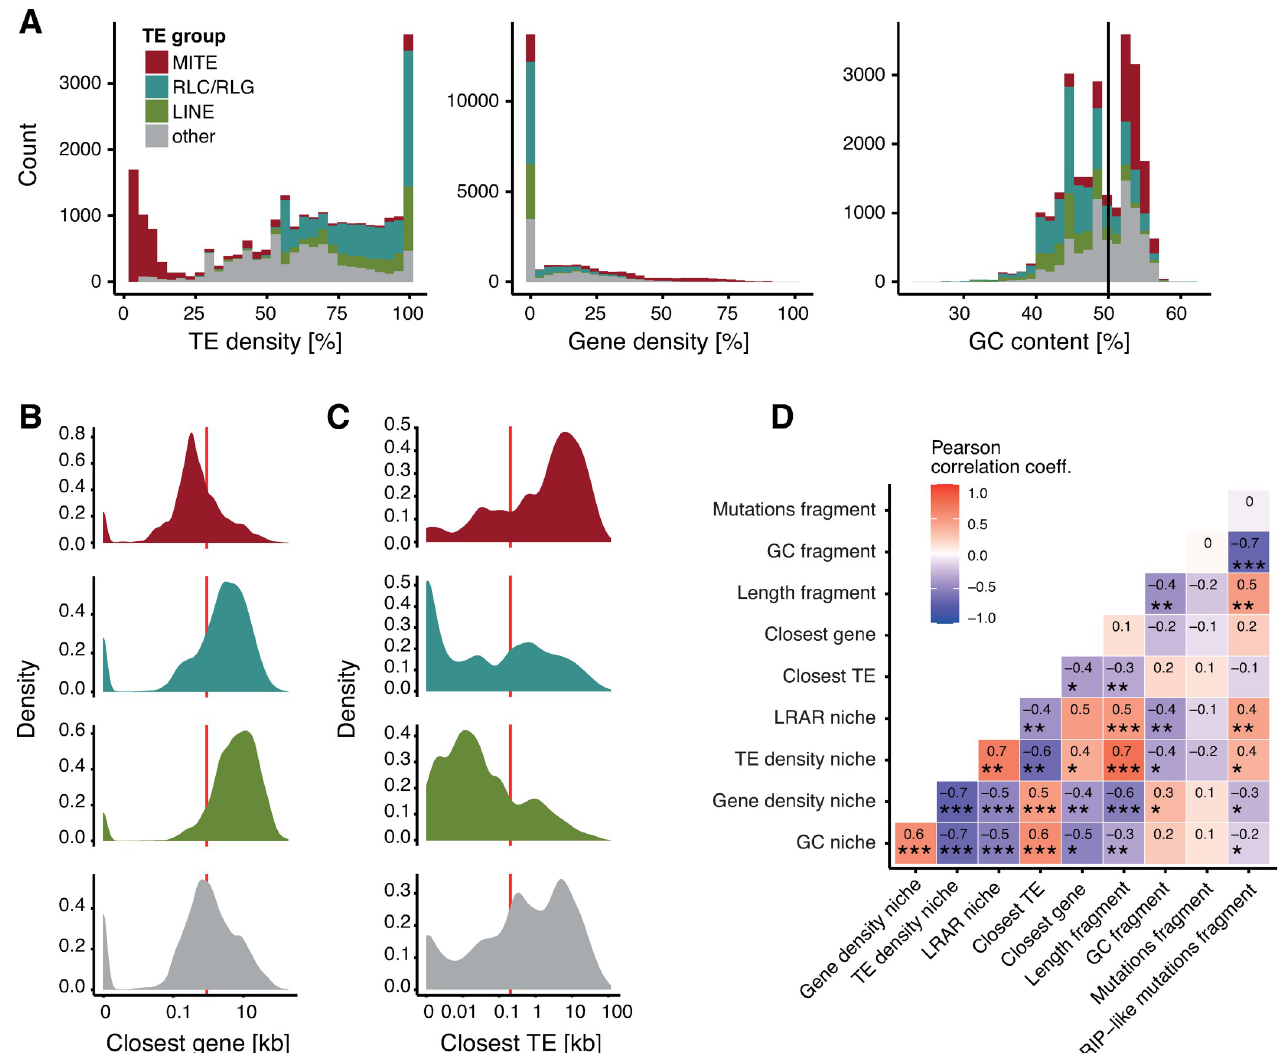
Fig 3. Distribution of niche and TE copy characteristics : (A) Overlap of TE content, gene content and GC content with TE copy niches. (B) Distribution of the distance to the closest gene in MITEs, RLC/RLG, LINE and other TEs. The red line indicates the mean distance. (C) Distances to the next TE MITEs, RLC/ RLG, LINE and other TEs. The red line indicates the mean distance. (D) Pearson correlation matrix of 11 characteristics of TE copy niches and TE copy characteristics. Dark red indicates strong positive correlation, dark blue indicates strong negative correlation of two characteristics. � p < 0.05, �� p < 0.01, ��� p <